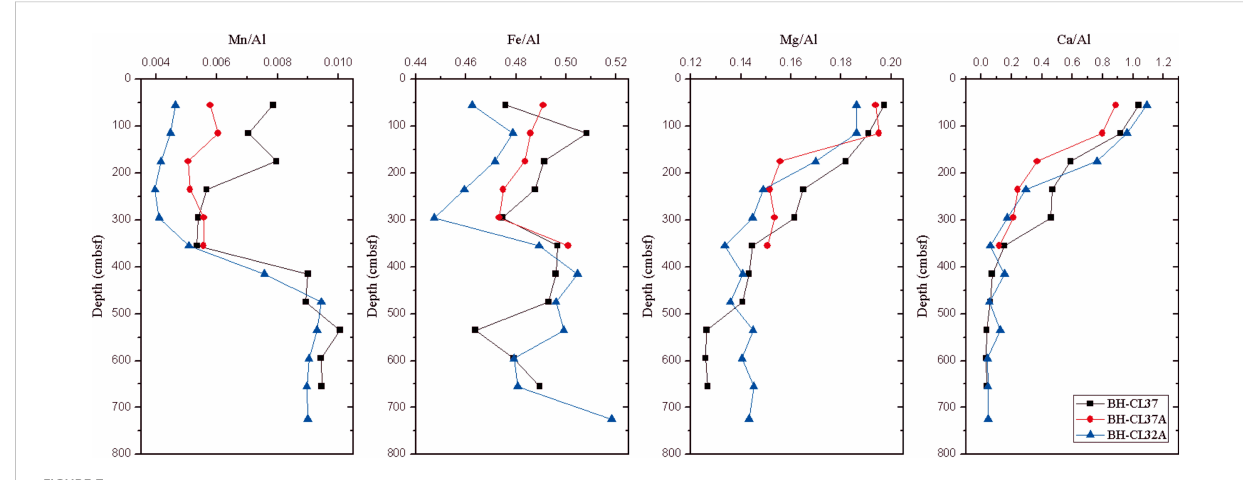
FIGURE 7 Images of the ratios of major elements to Al changing with